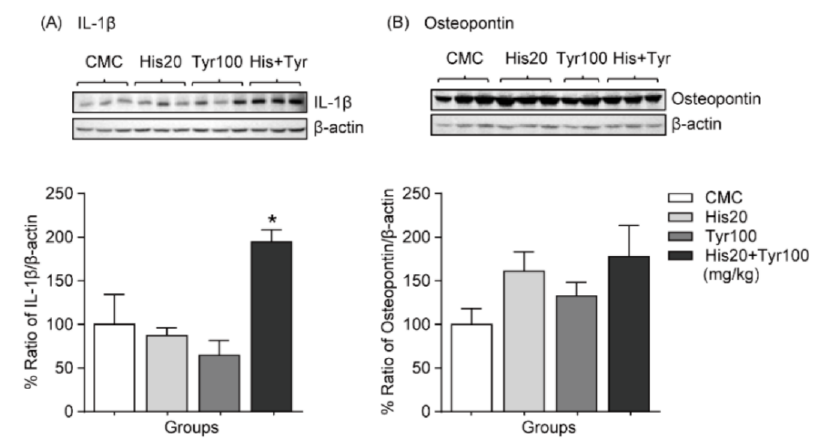
Figure 2. Effect of administration of single biogenic amines or their mixture on liver damage markers in mice fed an NCD. ( A ) Changes in IL-1 β expression levels after repeated oral gavage administrations of histamine, tyramine, and combined biogenic amines. ( B ) Osteopontin expression levels changed after oral gavage administrations of histamine, tyramine, and combined biogenic amines. * p < 0.05 vs. CMC. Data are shown as mean ± SEM. IL-1 β , interleukin-1 beta.